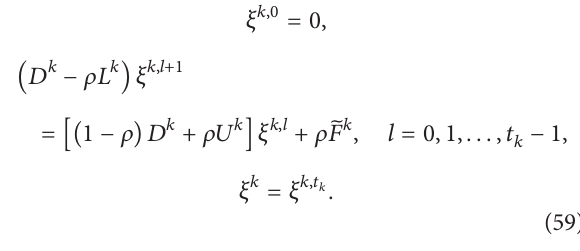
Algorithm 5 becomes nonsmooth SOR-Newton